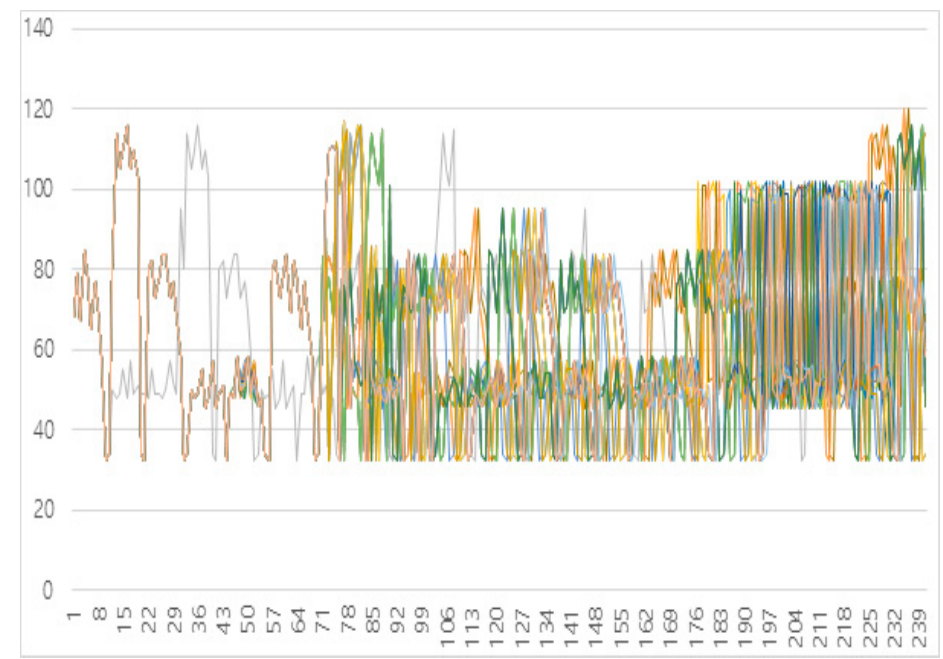
Figure 1. Example of converting the security log to the number of characters: the vertical axis is the number of words, the horizontal axis is the word dictionary; the word dictionary is created for words appearing in the current data.